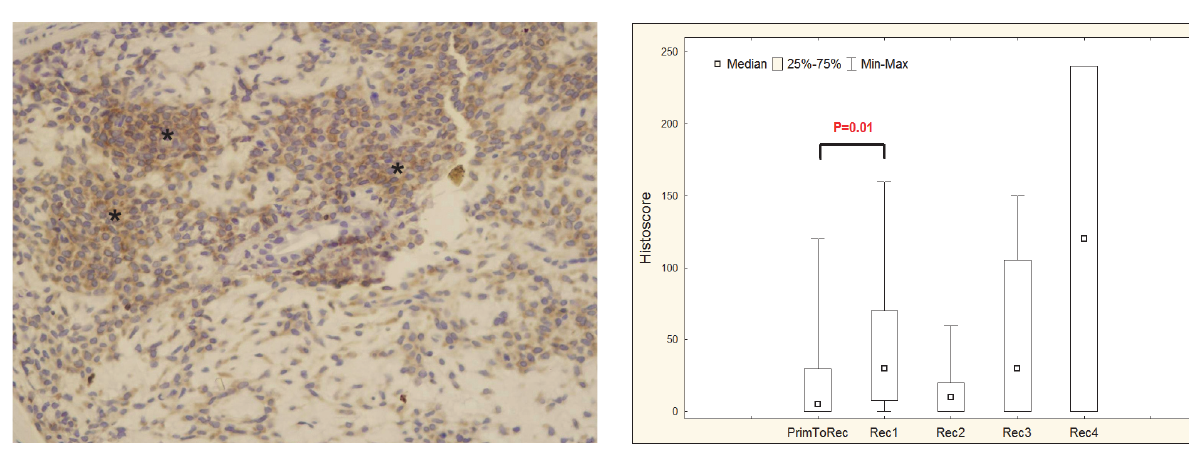
Fig. 4. Bcl-2 in aggressive recurrent pleomorphic adenoma. Aggressive multiple recurrent pleomorphic adenoma with a high bcl-2 histoscore. A myxoid nodule (asterisk) infiltrating soft tissue of the neck is composed almost exclusively of strong bcl-2 positive spindle and stellate cells. Bcl-2 positive tubular structures can be seen in the upper part of the fine tumour capsule. Original magnification, x